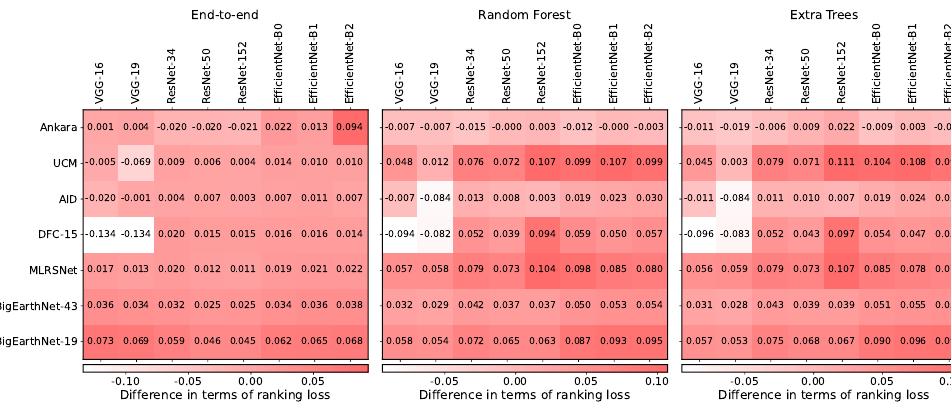
Figure 6. Comparison between fine-tuning and pre-training in terms of ranking loss. The results for the different architectures are presented in the form of a heat map showing the difference in performance between the learning approaches. Negative values indicate that pre-training is better than fine-tuning and positive when fine-tuning is better than pre-training. The intensities of the colors in the heat map are directly related to the difference in performance between the learning approaches (CNN architectures). The datasets on the y-axis are ordered by the number of images they contain.